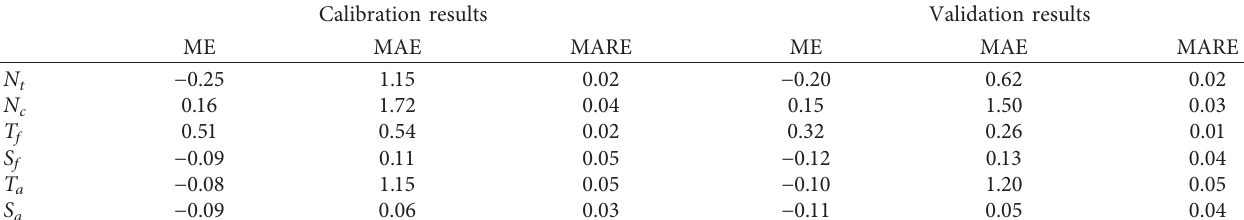
Table 4: Evaluation results of work zone social force model.